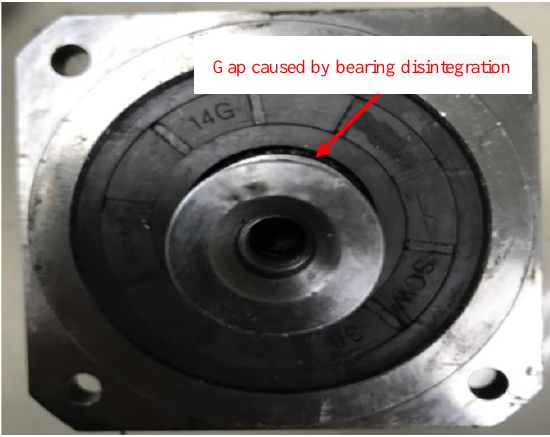
Figure 20. Faulty reducer.